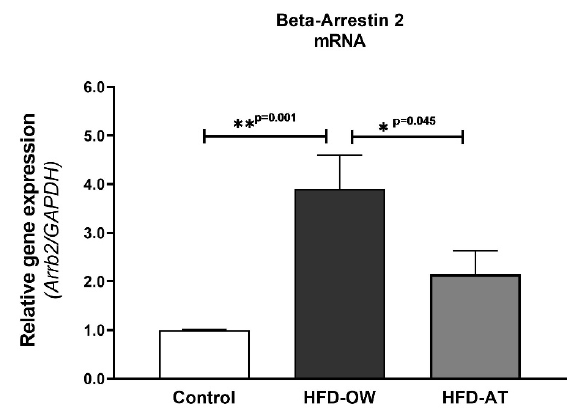
Figure 1. Bodyweight during the experiment period. CON: Control (n=7); HFD-OW: High-fat diet-induced overweight; HFD-AT: a high-fat diet with aerobic training. Data are presented as mean±SEM. Data were analyzed by one-way ANOVA followed by Tukey's test. ** P < 0.01 compared to the control group.